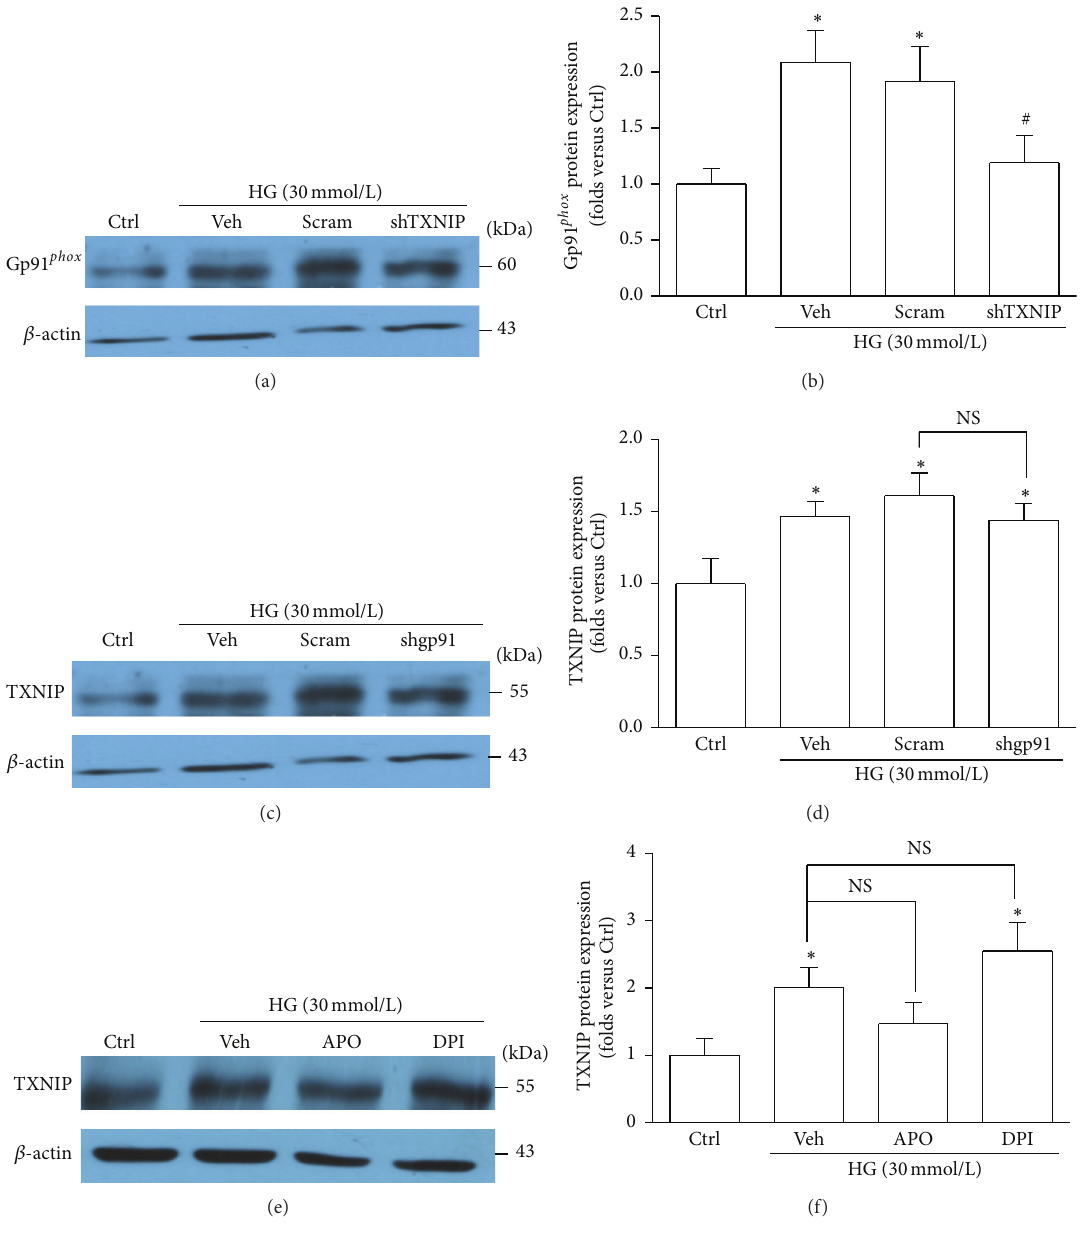
Figure 6: Inhibition of TXNIP abolishes the HG-triggered upregulation of gp 91 𝑝ℎ𝑜𝑥 . (a) Western blot analysis showing the expression of gp 91 𝑝ℎ𝑜𝑥 in HG-exposed podocytes without or with TXNIP shRNA transfection. (b) Summarized data showing the band intensities measured from gp 91 𝑝ℎ𝑜𝑥 ( 𝑛 = 6 ). (c) Western blot analysis showing the expression of TXNIP in HG-stimulated podocytes without or with gp 91 𝑝ℎ𝑜𝑥 shRNA transfection. (d) Summarized data showing the band intensities measured from TXNIP ( 𝑛 = 6 ). (e) Protein expression of TXNIP in HG-stimulated podocytes without or with pretreatment of APO or DPI. (f) Summarized data showing the band intensities of TXNIP ( 𝑛 = 4–6). Ctrl: control; HG: high glucose; Veh: vehicle; Scram: scrambled shRNA; shTXNIP: TXNIP shRNA; shgp91: gp 91 𝑝ℎ𝑜𝑥 shRNA; APO: apocynin; DPI: diphenyleneiodonium. ∗ 𝑃 < 0.05 compared with Ctrl; # 𝑃 < 0.05 compared with HG group treated with vehicle or transfected with scramble